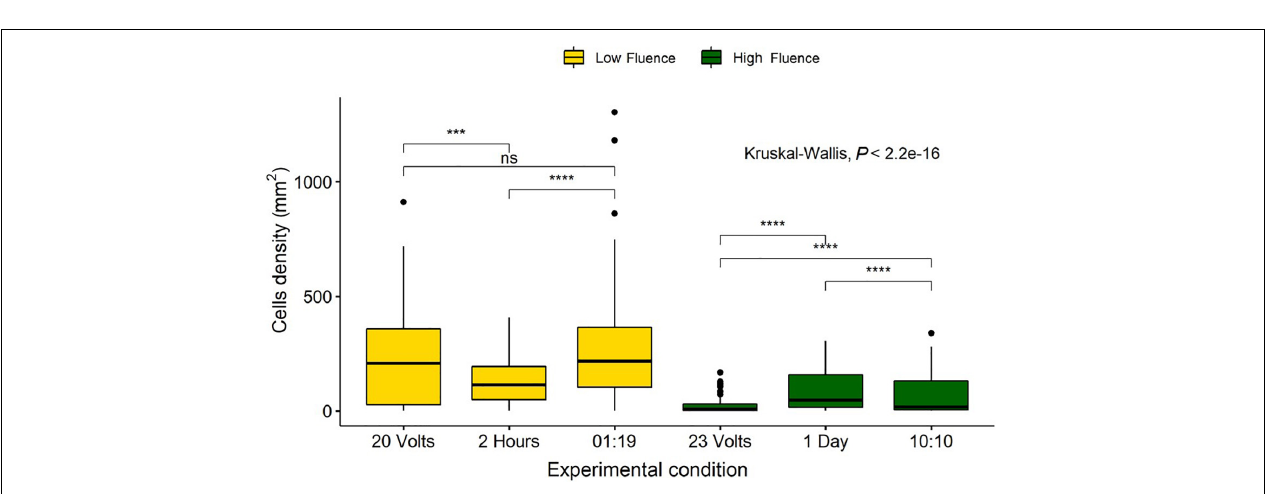
FIGURE 10 | Comparison of Navicula incerta cell densities remaining on the surface after low and high irradiance exposures. Low fluence grouped based on fluence of 0.82, 0.78, and 0.94 J/cm 2 for 20 volts, 2 h, and a 01:19 duty cycle, respectively. High fluence grouped based on fluence of 11.12, 9.35, and 9.35 J/cm 2 for 23 volts, 1 day, and a 10:10 duty cycle, respectively. Kruskal-Wallis value displayed with Wilcoxon pairwise comparison arranged above groupings (ns, not significant, *** P < 0.001, **** P <